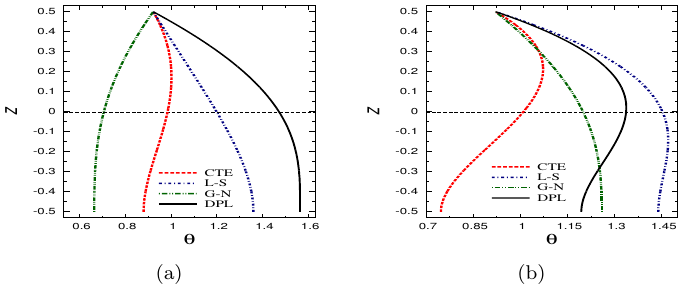
Figure 3. The temperature distributions in the thickness direction for beams under (a) thermal load and (b) thermomechanical load.